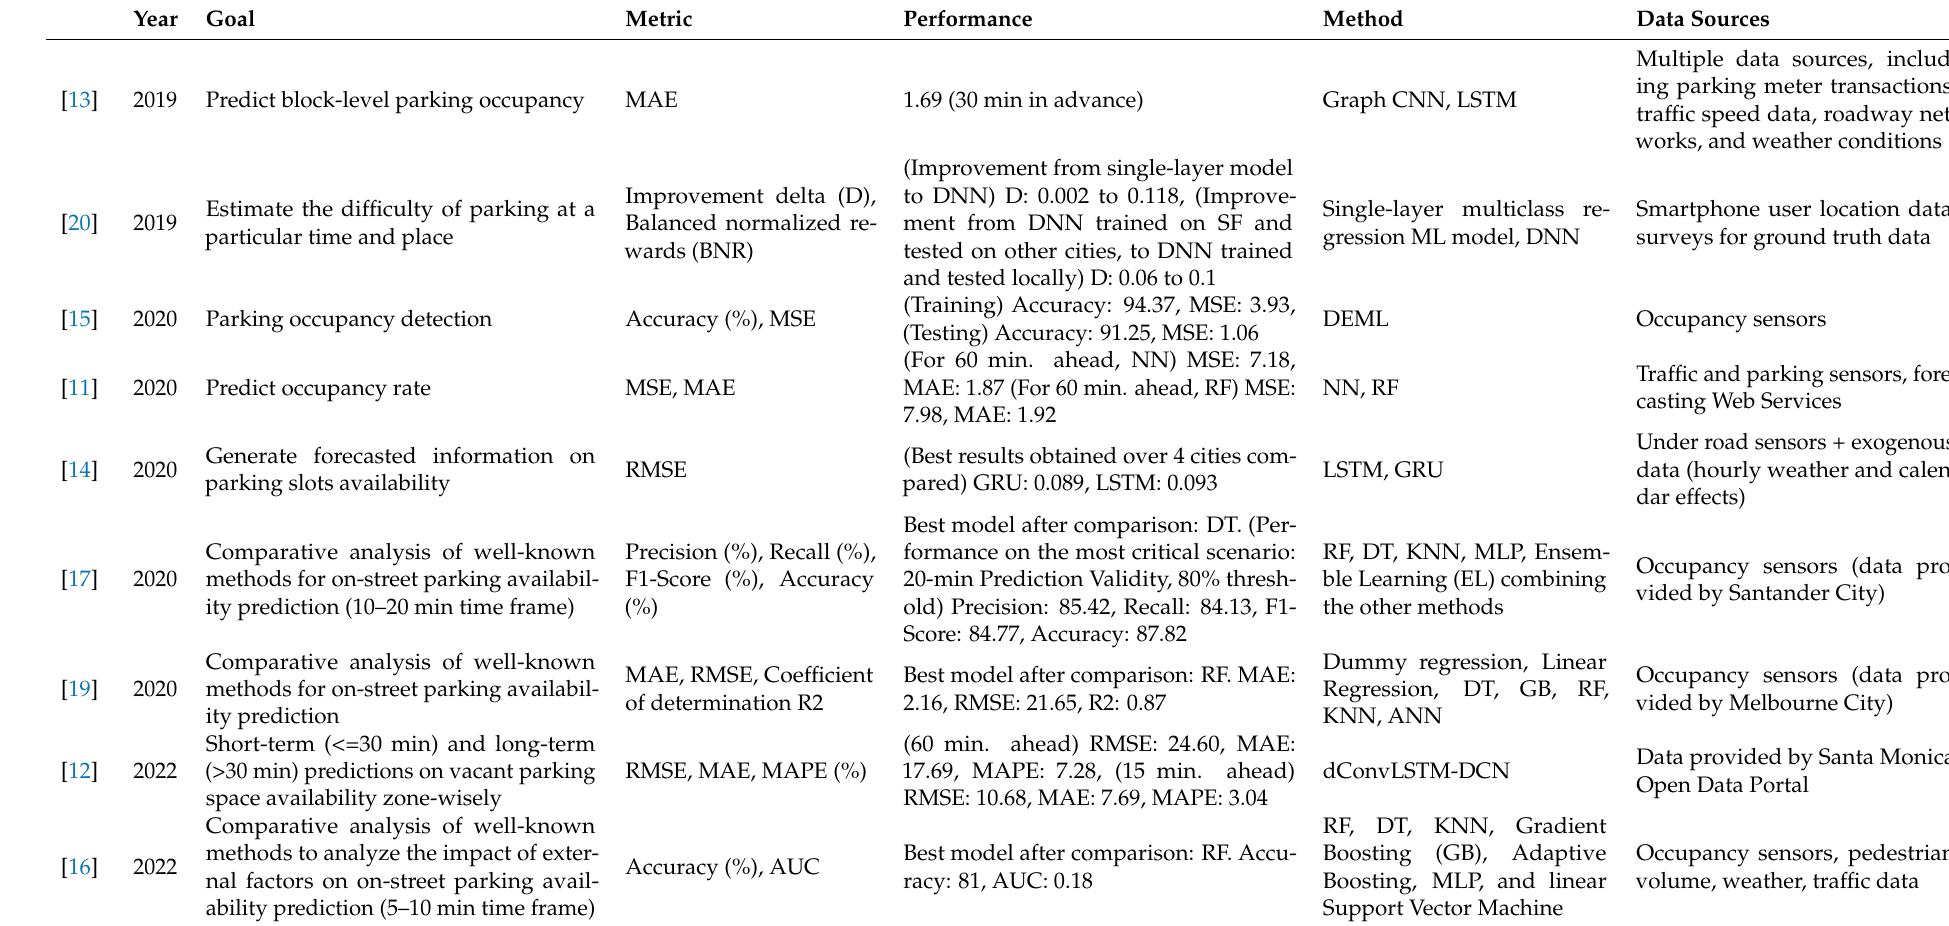
Table 1. Extension of the table presented in [11]; comparison of related works after